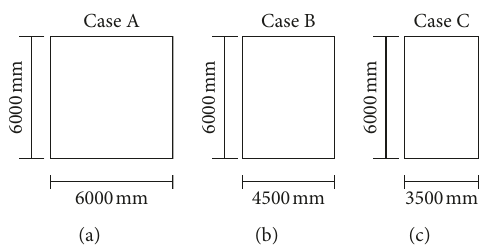
Figure 2: The three cases to be designed. (a) Case A. (b) Case B. (c) Case